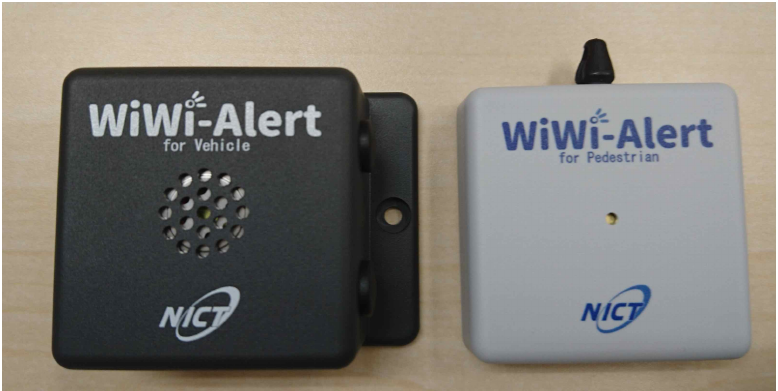
Figure 7. The prototype devices for a vehicle ( left ) and a pedestrian ( right ). The size of both devices is 5 cm × 5